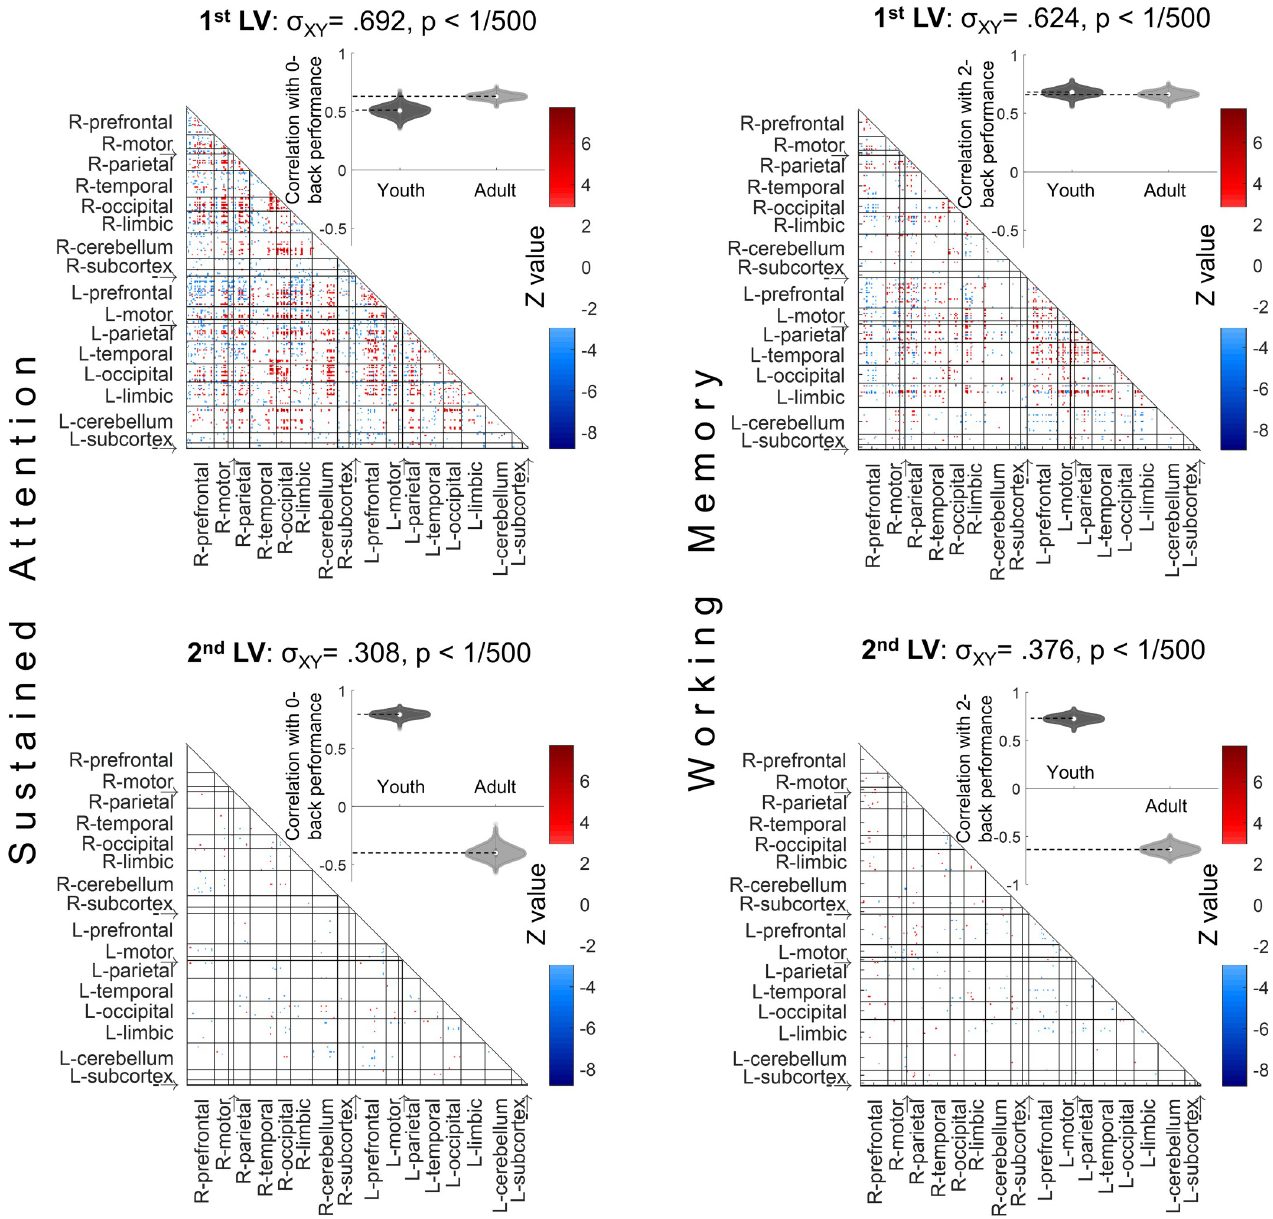
Fig 7. The data-driven LVs for the sustained attention (left column) and working memory (right column) PLS regressions. Left column: PLS relating functional connectivity to SA performance and age group successfully identified functional connectivity patterns related to better attentional performance in both ABCD youth and HCP adults (first LV), as well as connections differentially related to performance in youth and adults (second LV). Right column: PLS relating functional connectivity to WM performance and age group successfully identifies functional connectivity patterns related to better WM performance in both youth and adults (first LV), as well as connections differentially related to performance in youth and adults (second LV). P values are calculated from 500 permutations and LV weights are calculated from 500 bootstraps in each PLS; significant connections are those that have bootstrap ratios (Z) above +3 or below − 3. We randomly selected 754 of the ABCD sample in each PLS to make the age group sizes balanced (HCP has n = 754) and the presented figure is averaged over 200 bootstrapped balanced samples. Using the full 1,545 ABCD participants instead of randomly balanced group sizes results in very similar PLS LVs. Anatomical labels: R and L refer to right and left hemispheres; “ ! ” is insula and “- ! ” is brainstem. The data for this figure are available at NDA study 1849 10.15154/1528288. ABCD, Adolescent Brain Cognitive Development; HCP, Human Connectome Project; LV, latent variable; PLS, partial least squares; SA, sustained attention; WM, working